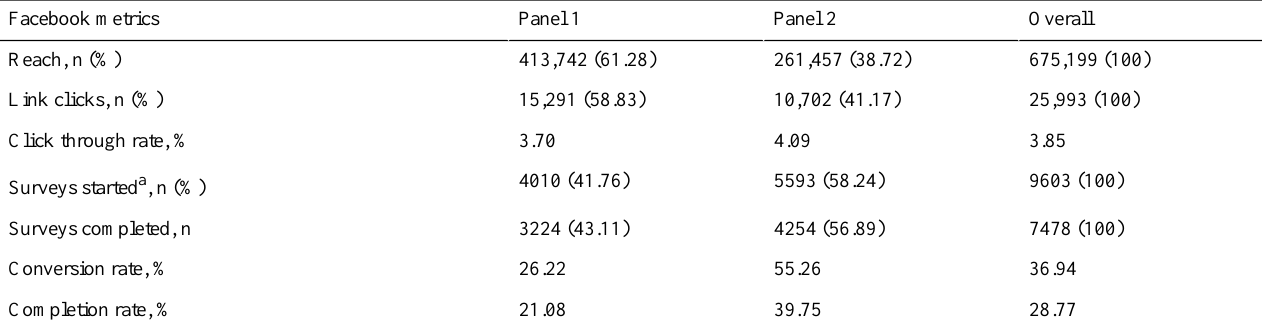
Table 1. Facebook recruitment advertisement performance across all